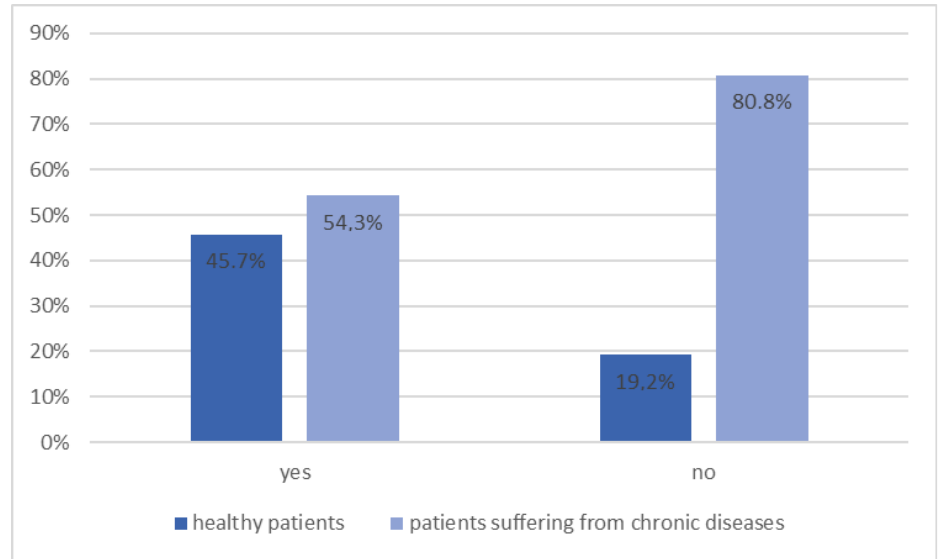
Figure 9. Distribution of chronic diseases among patients depending on whether their blood glucose level has ever been tested ( n = 131, p = 0.010).